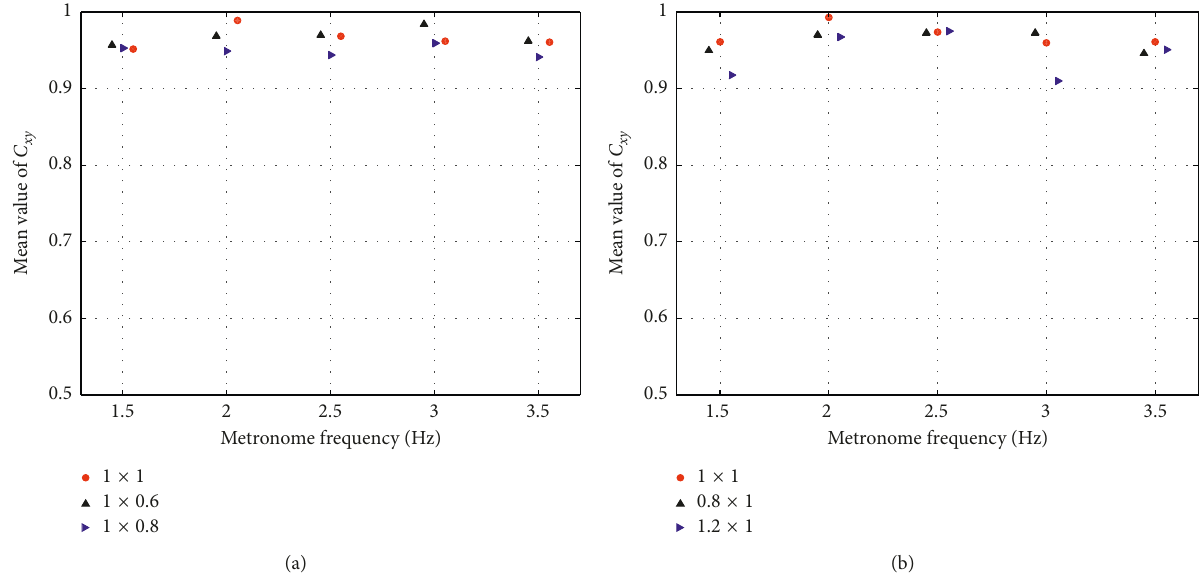
Figure 30: Comparison of the mean values of the coherence coefficient with a single distance in two groups. (a) Group 01; (b) group 02.